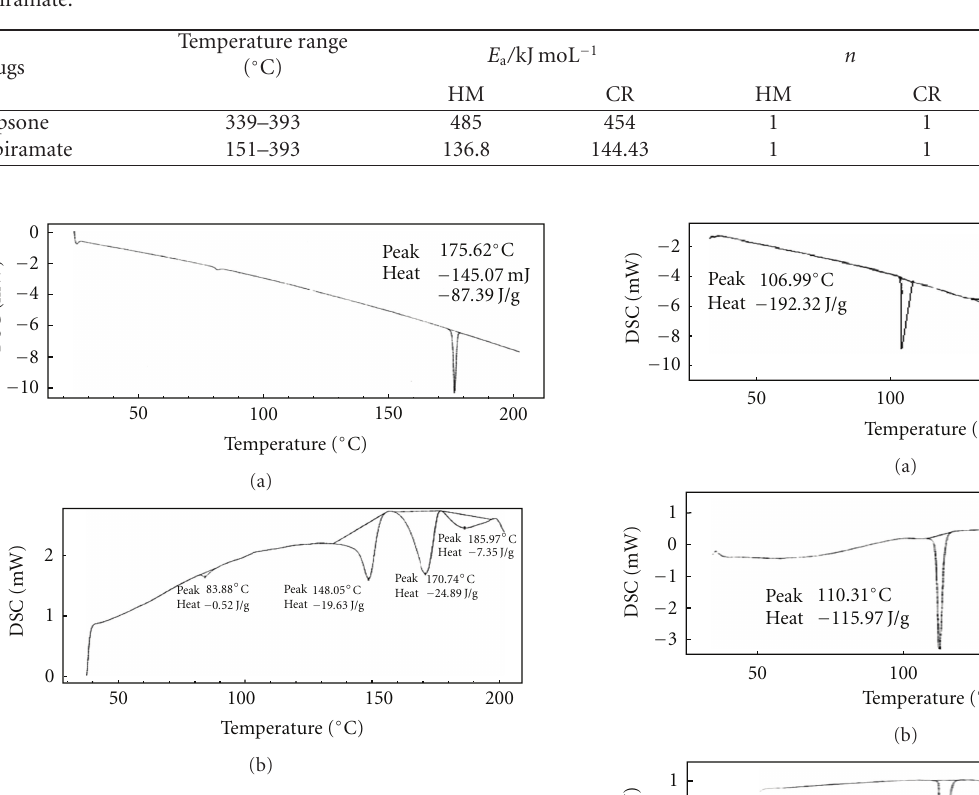
Figure 2: DSC profile of Dapsone drug substance (a), and Dapsone tablet (b).